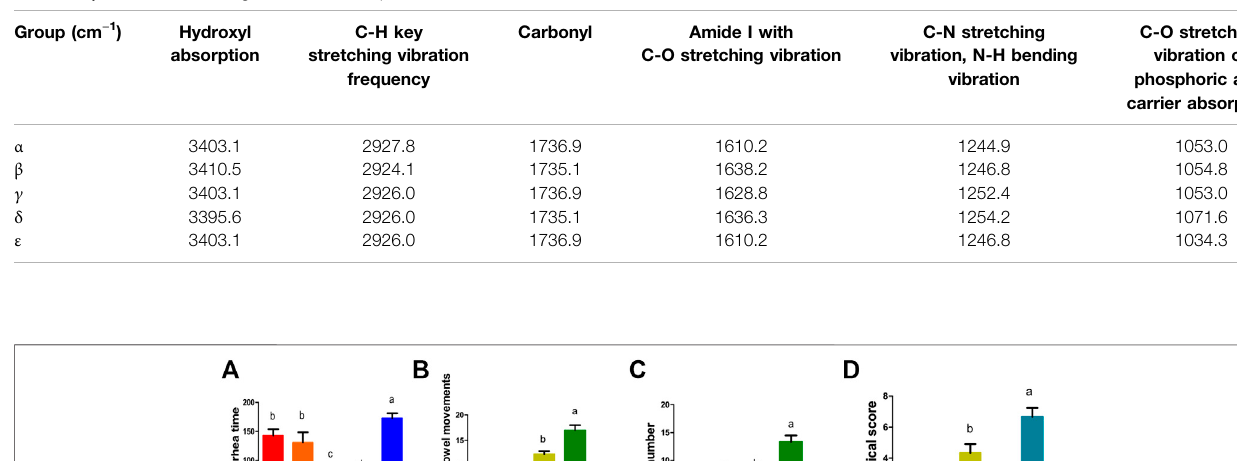
TABLE 5 | Wave number assignments of FTIR spectra of PSPs with different sizes.